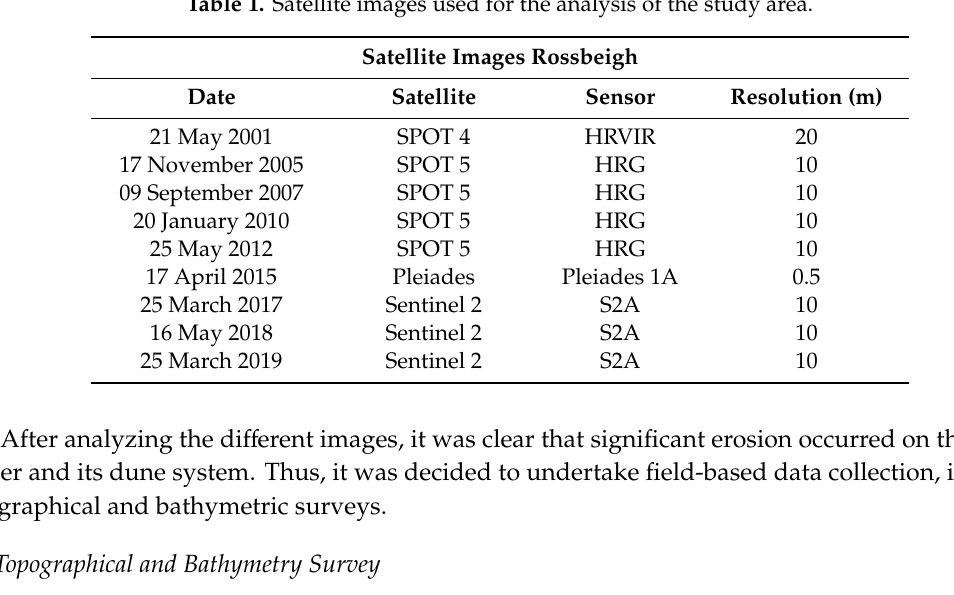
Table 1. Satellite images used for the analysis of the study